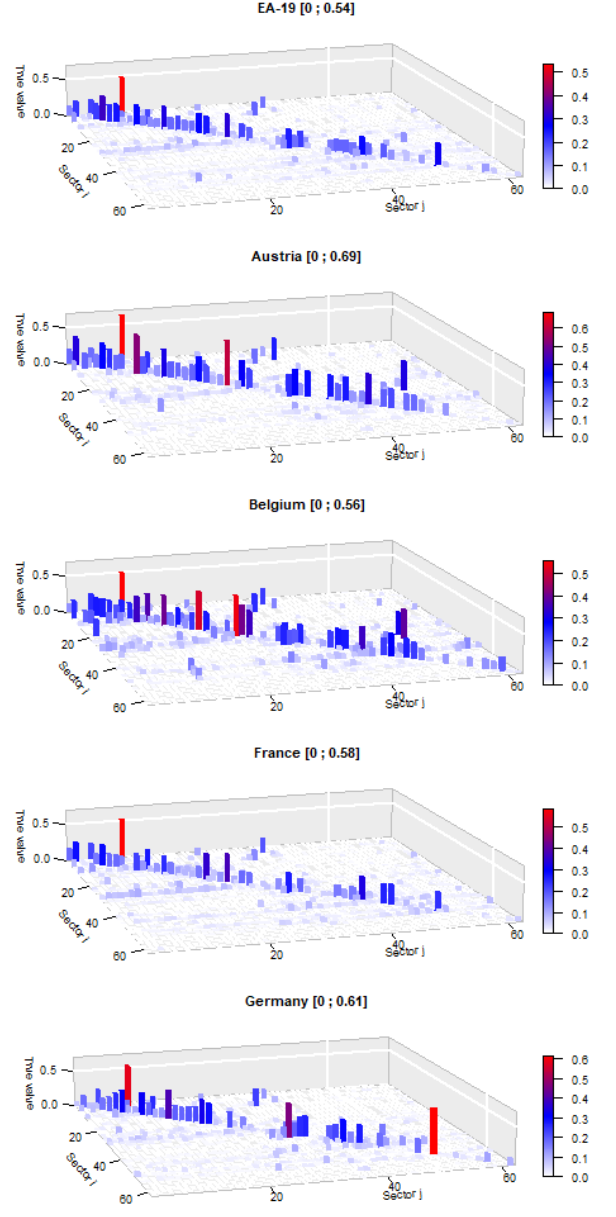
Figure 1. Viewing the true EA-19 technical coefficients (2015). Source: internal based on Eurostat data [naio_10_cp1700].